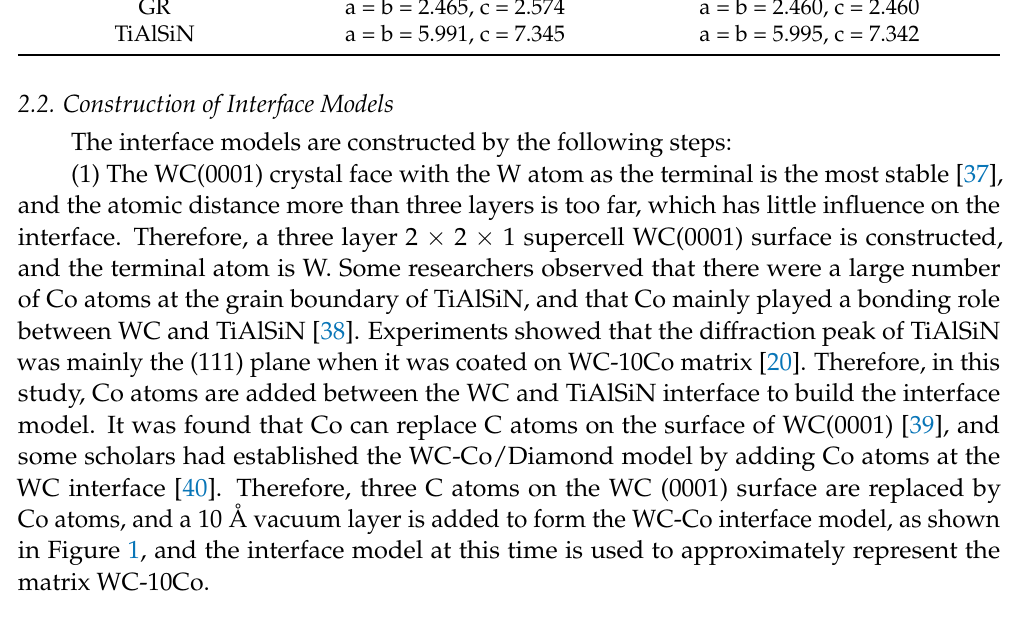
Figure 1. WC-Co interface model with vacuum layer.